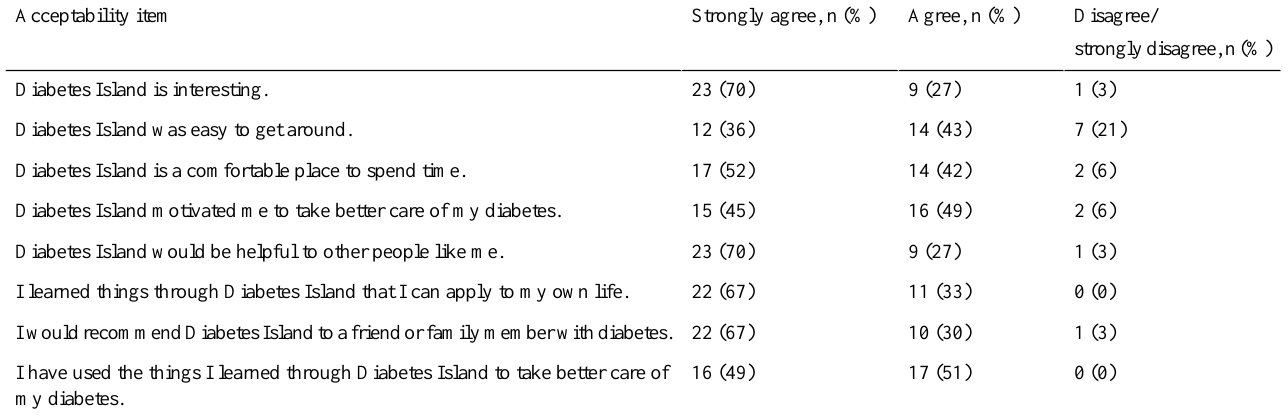
Table 3. Results of acceptability survey